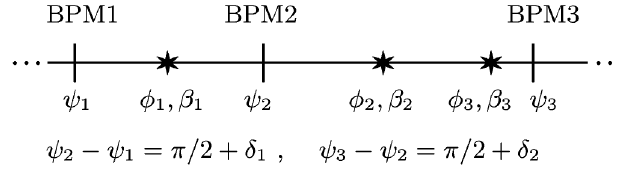
FIG. 1. Segment of an accelerator lattice. BPMs and multi- poles are shown with their relevant Twiss